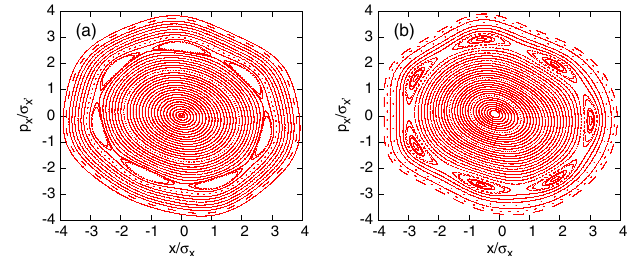
FIG. 7. Phase space ( x − p x ) plot for the crossing-angle (a) and offset collision